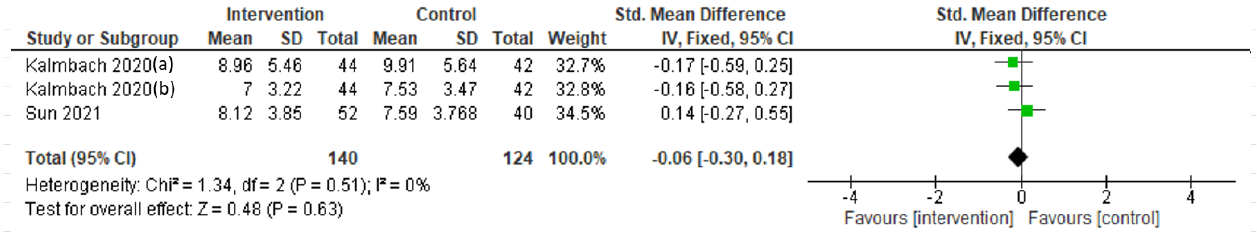
Figure 6. Sleep quality at the 6-month postpartum follow-up: Kalmbach 2020 (a, [66]) = ISI; Kalmbach 2020 (b, [66]) = PSQI. Figure 5 . Sleep quality at the endpoint: Kalmbach 2020 (a, [66]) = ISI; Kalmbach 2020 (b, [66]) = PSQI.